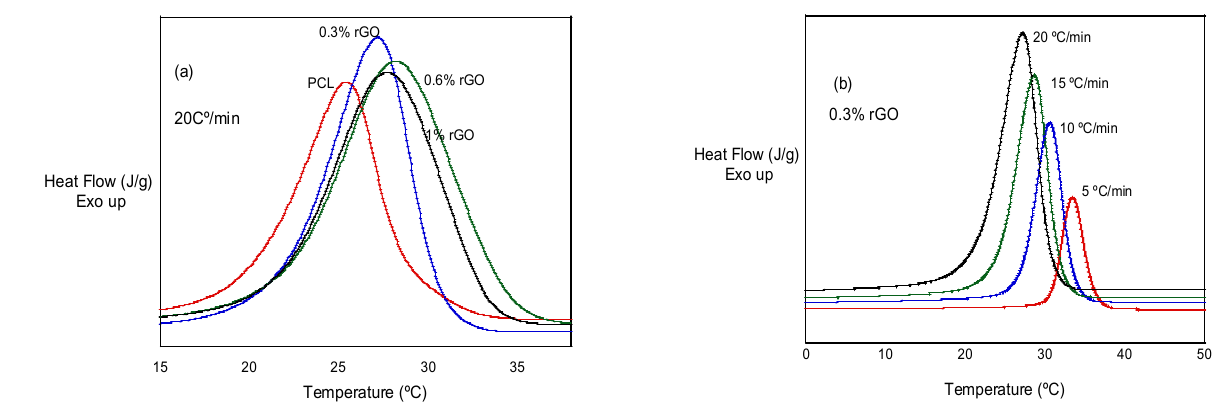
Figure 3. ( a ) Non ‐ isothermal crystallization behavior of PCL and its composites with rGO at 20 °C/min. ( b ) Non ‐ isothermal crystallization behavior of PCL/0.3% rGO at different heating rates. The non ‐ isothermal crystallization temperature, Tp, decreased as the cooling rate in ‐